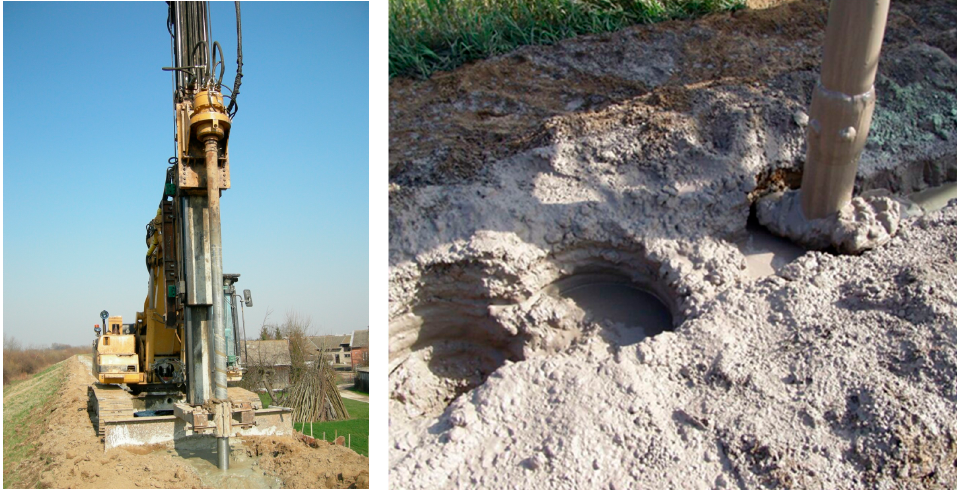
Figure 15. Making a column using the deep soil mixing method (by Ł ukasz